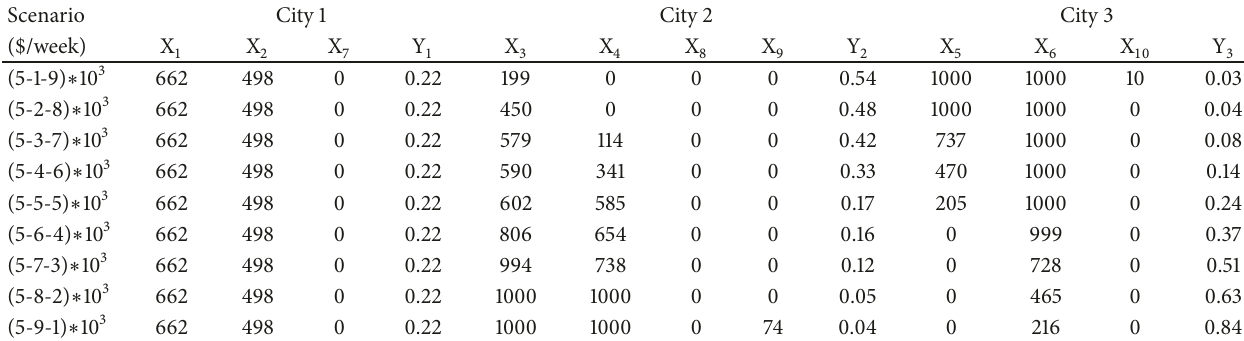
Table 4: Optimal solutions for decentralized decision model under different budget allocation.